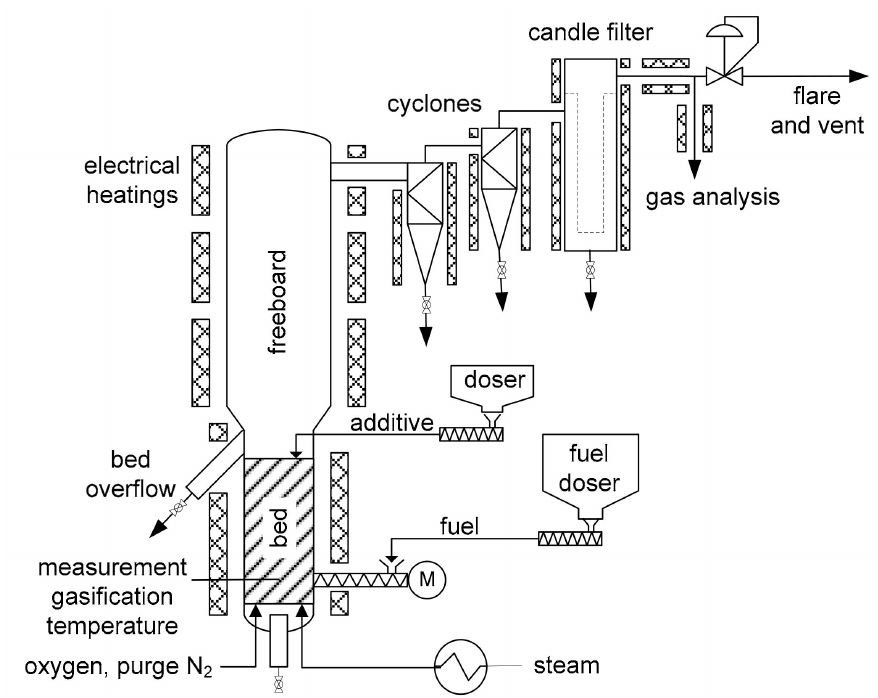
Figure 1. 20 kW fluidized bed gasification